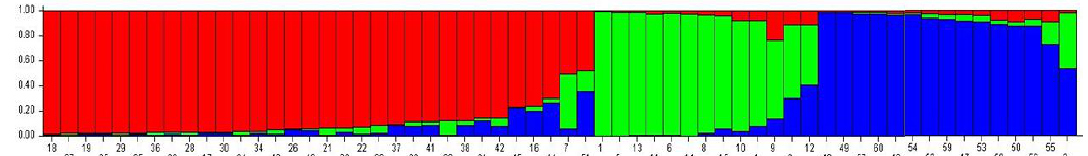
Figure 6. The genetic relationships among the 60 argan tree among the four provenances estimated using the STRUCTURE program based on ISSR data (red: A and H; green: JB; blue: S). The assignment of individuals to genetic clusters at K = 3, with the y-axis representing genetic distance and the x-axis the accession and subgroup indicated by color, and with each color representing a single gene pool.